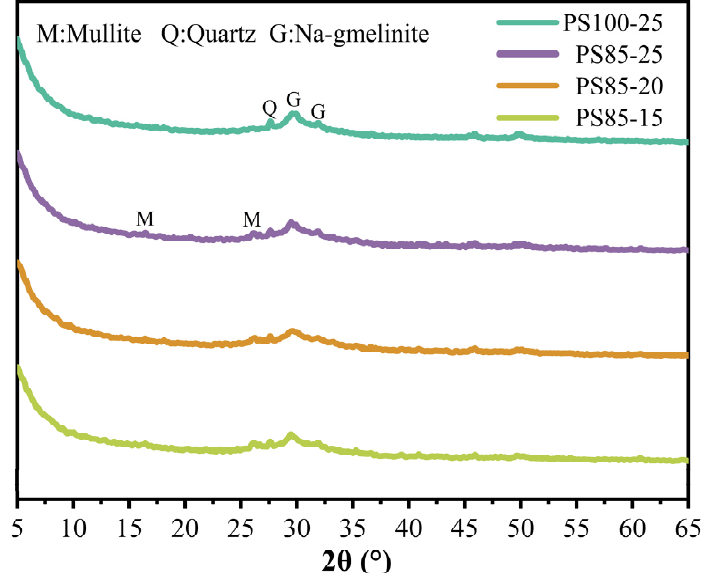
Figure 9. XRD patterns of WUFA-PS and PS-based geopolymers at 28 days.